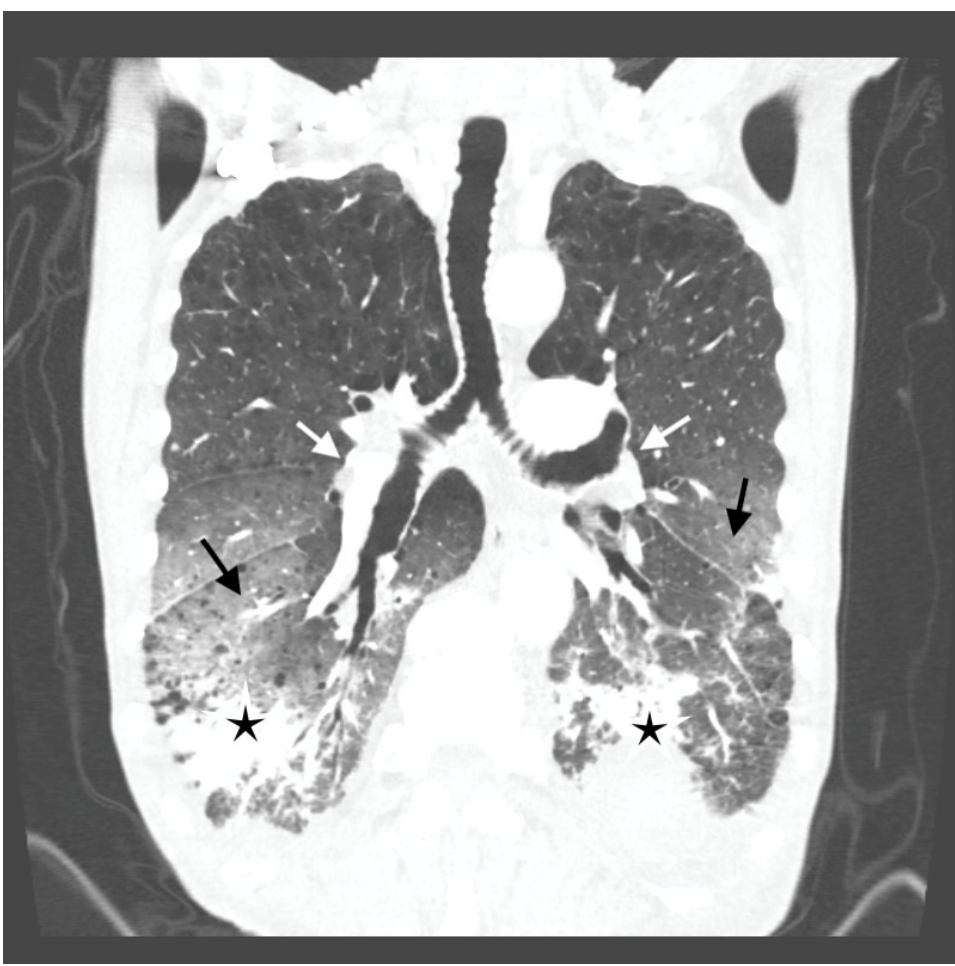
Figure 2. Computed tomography (CT) scan of the chest showing bilateral hilar adenopathy (white arrows), massive bilateral ground glass opacities in the middle and lower parts of the lungs (black arrows) accompanied by parenchymal infiltrations (black asterisks) and bronchial walls thickening.